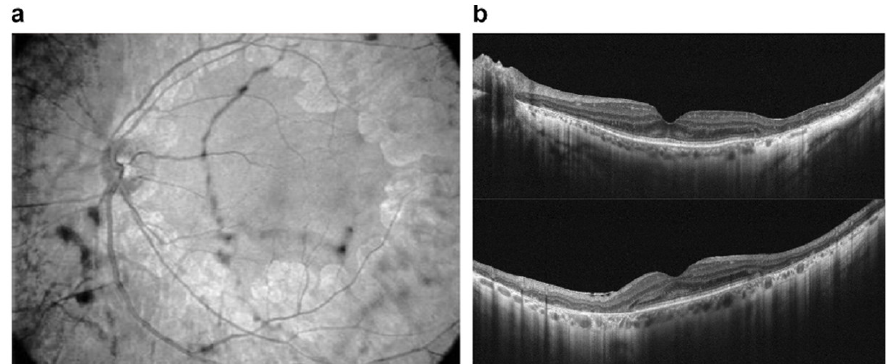
Figure 5. Multimodal imaging: ( a ) infrared light retinography shows confluent plaques of chorioretinal atrophy in posterior pole, with the macular area more preserved; ( b ) OCT shows marked impairment of the outer neurosensory retinal layer, retinal pigmented epithelium, and perifoveal choroid. Diffuse thinning is seen with marked atrophy of the outer nuclear layer, external limiting membrane, and ellipsoid zone. Diffusely increased posterior light reflectance demonstrates associated retinal pigmented epithelium atrophy. The foveal area maintains normal architecture but shows slightly increased internal reflectivity of the outer nuclear layer.